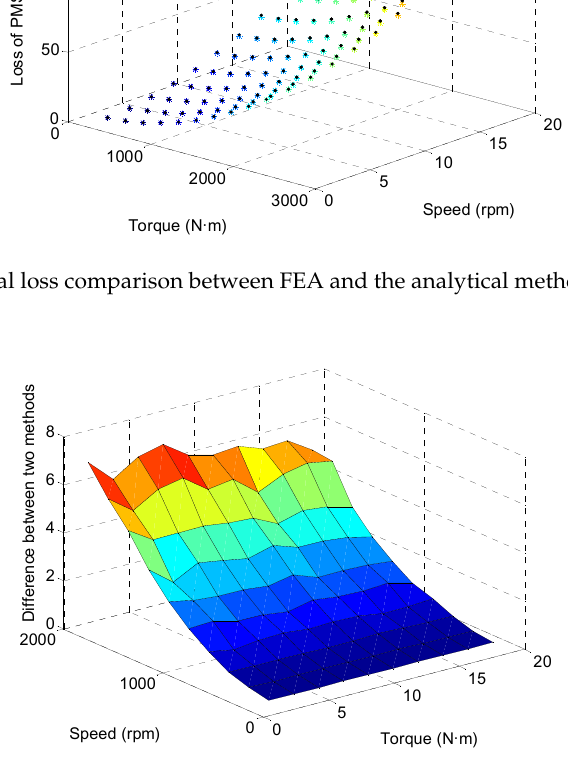
Figure 5. Difference of motor loss between the FEA method and the proposed analytical method at different speeds and torques.